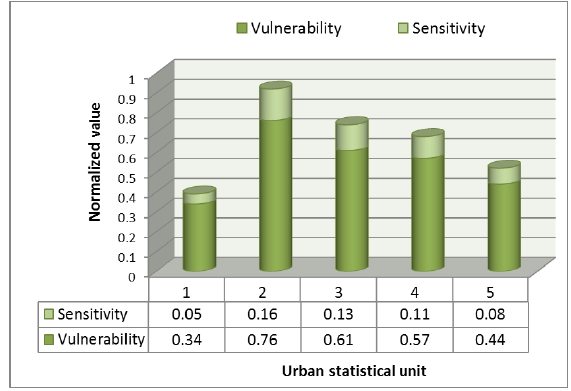
Figure 3. Sensitivity and vulnerability measures for five randomly selected statistical units